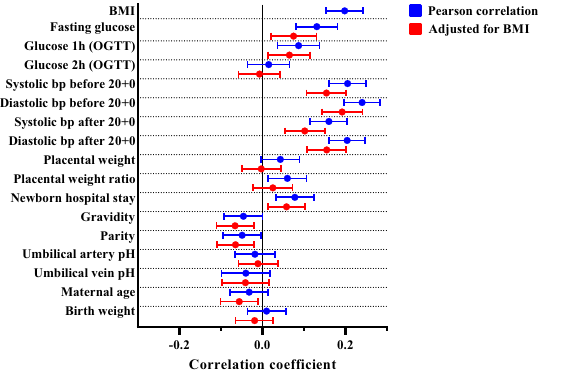
Figure 1. Associations of Hb levels with maternal metabolic parameters and perinatal outcome. Forest plots representing the effect sizes and their 95% confidence interval with Pearson correlation (blue) or partial correlation adjusted for BMI (red). BMI body mass index, OGTT oral glucose tolerance test, bp blood